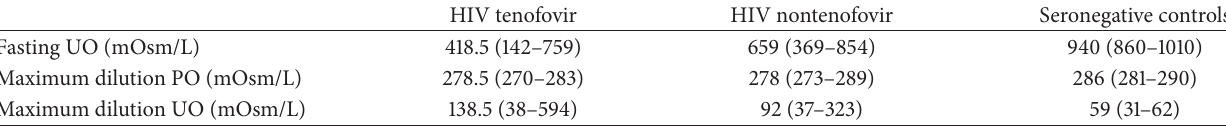
Table 3: Plasma and urine osmolarity values in HIV groups.